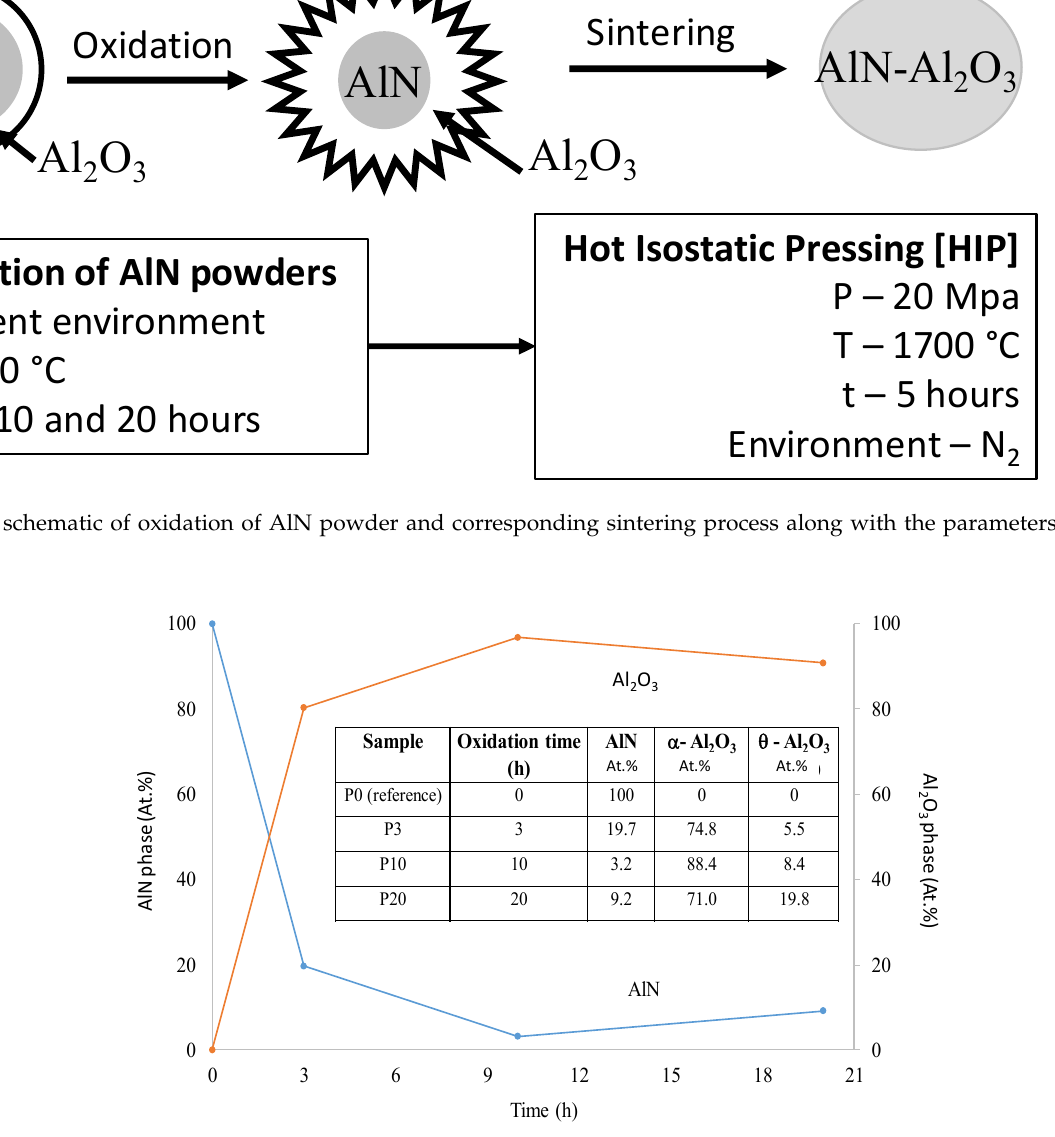
Figure 2. The change and phase transformation observed in the AlN and α‐ Al 2 O 3 phases as function of oxidation time as shown in the table in the inset. Table 1. Apparent density of the sintered samples shown as function of oxidation